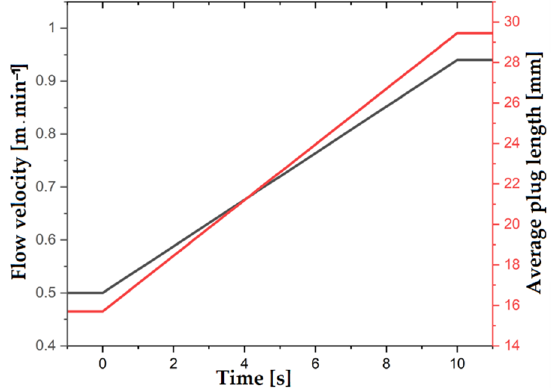
Figure 21. Dynamic change of the target speed and the target slug length throughout the changeover process.